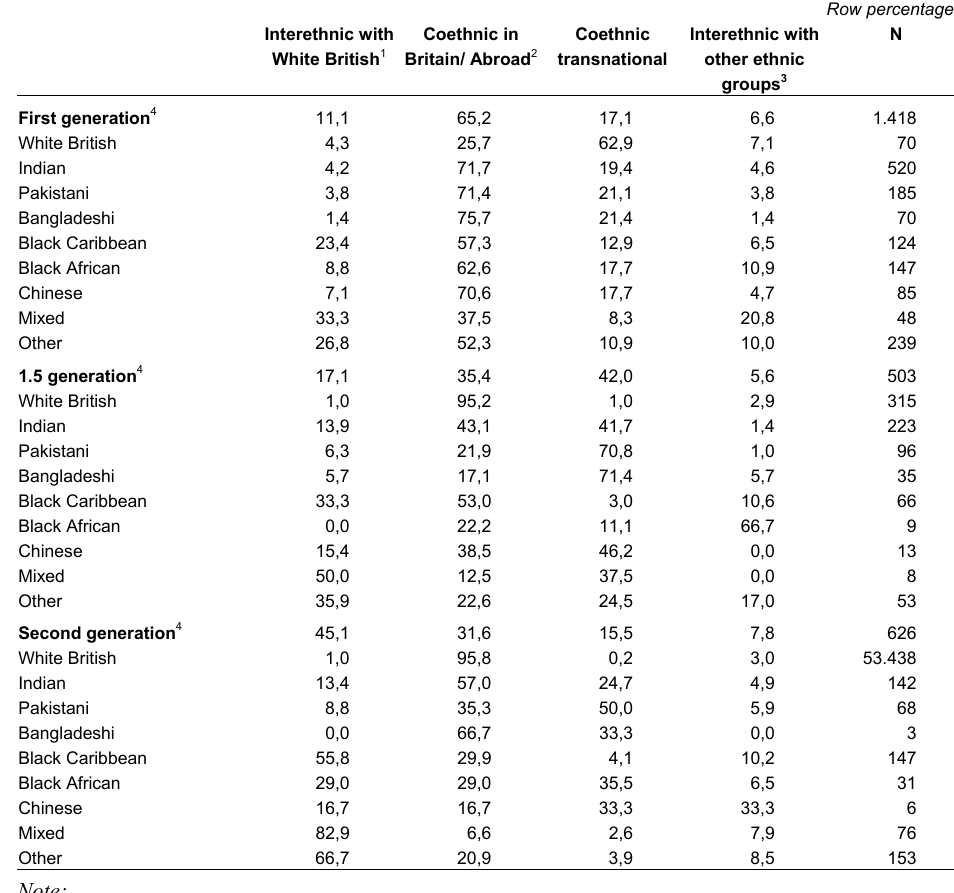
Table 1: Percentage distribution of types of unions by ethnic groups and generation (Male) Row percentages Interethnic with Coethnic in Coethnic Interethnic with N White British 1 Britain/ Abroad 2 transnational other ethnic groups 3 First generation 4 11,1 65,2 17,1 6,6 1.418